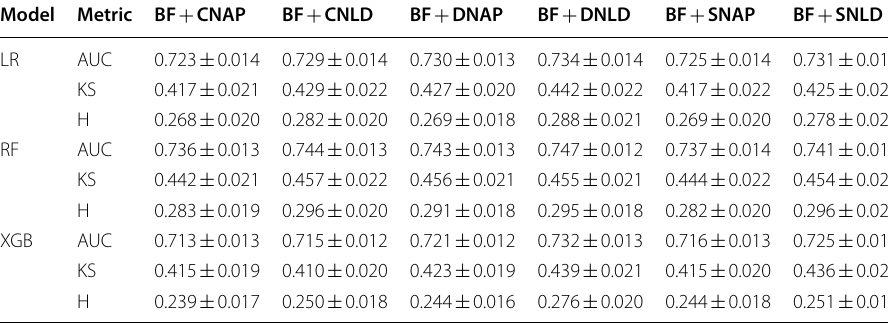
Each metric are measured in mean of 100 estimates obtained by repeating the outer ten-fold cross-validation procedure ten times(mean standard deviation from a 95% confidence interval) ± Table 28 Discrimination performance of different feature sets under 90% confidence intervals